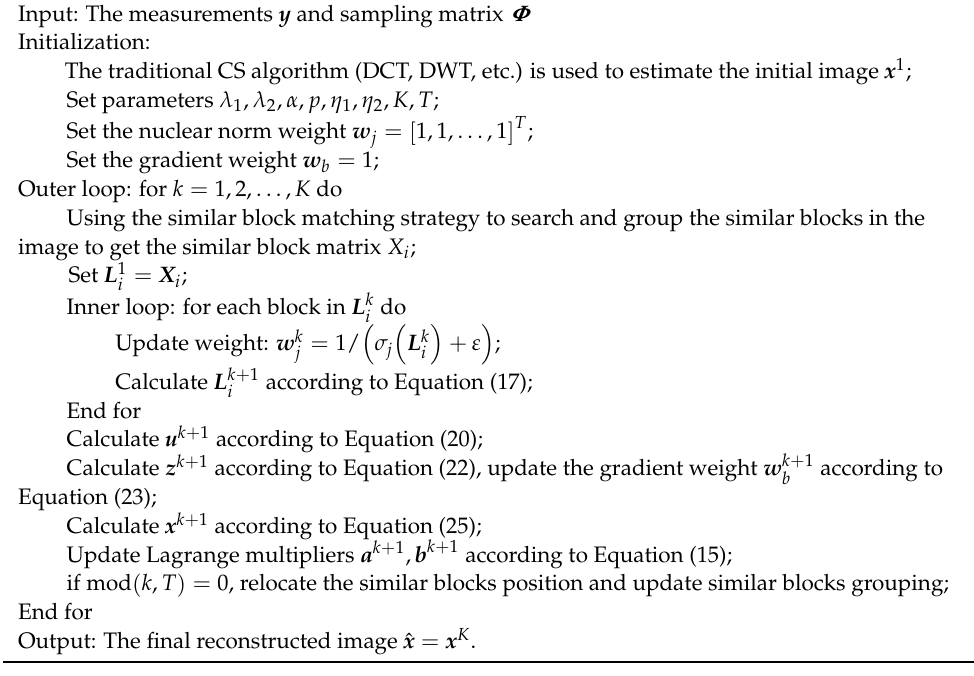
Algorithm 1: The proposed CS reconstruction